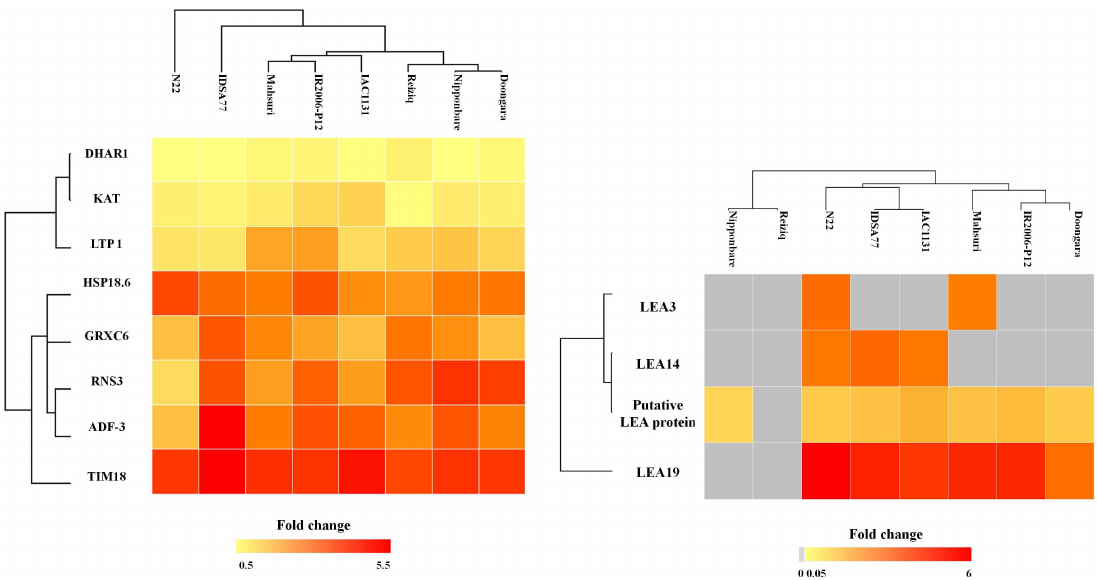
Figure 2. Globally upregulated proteins’ and late embryogenesis abundant (LEA) proteins’ expression pattern in drought stress. ( a ) Eight stress-responsive proteins significantly increased in abundance in all genotypes under drought stress. ( b ) Four members of LEA proteins significantly altered in response to drought stress. The fold change was calculated from the ratio of the average NSAF value in drought stress to the average NSAF value in the control condition for each of the proteins in each of the eight genotypes indicated. No protein was identified in the gray boxes. Heat maps were generated in Perseus (v. 1.6.0.2) using the log 2 NSAF fold changes [13]. Hierarchical clustering was performed using Euclidean as the distance metric and average as the linkage